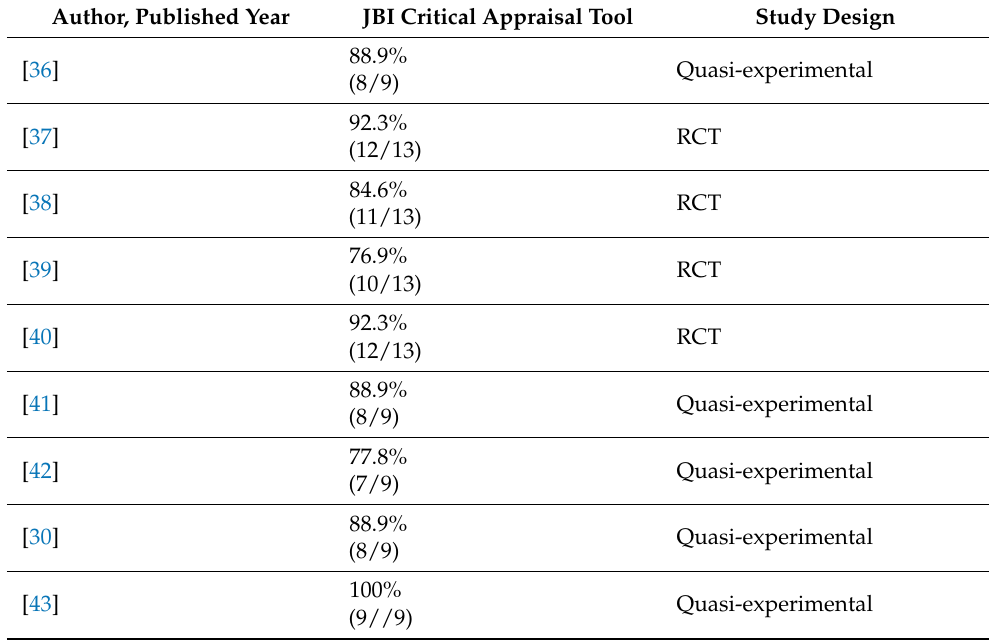
Table 1. JBI Critical Appraisal